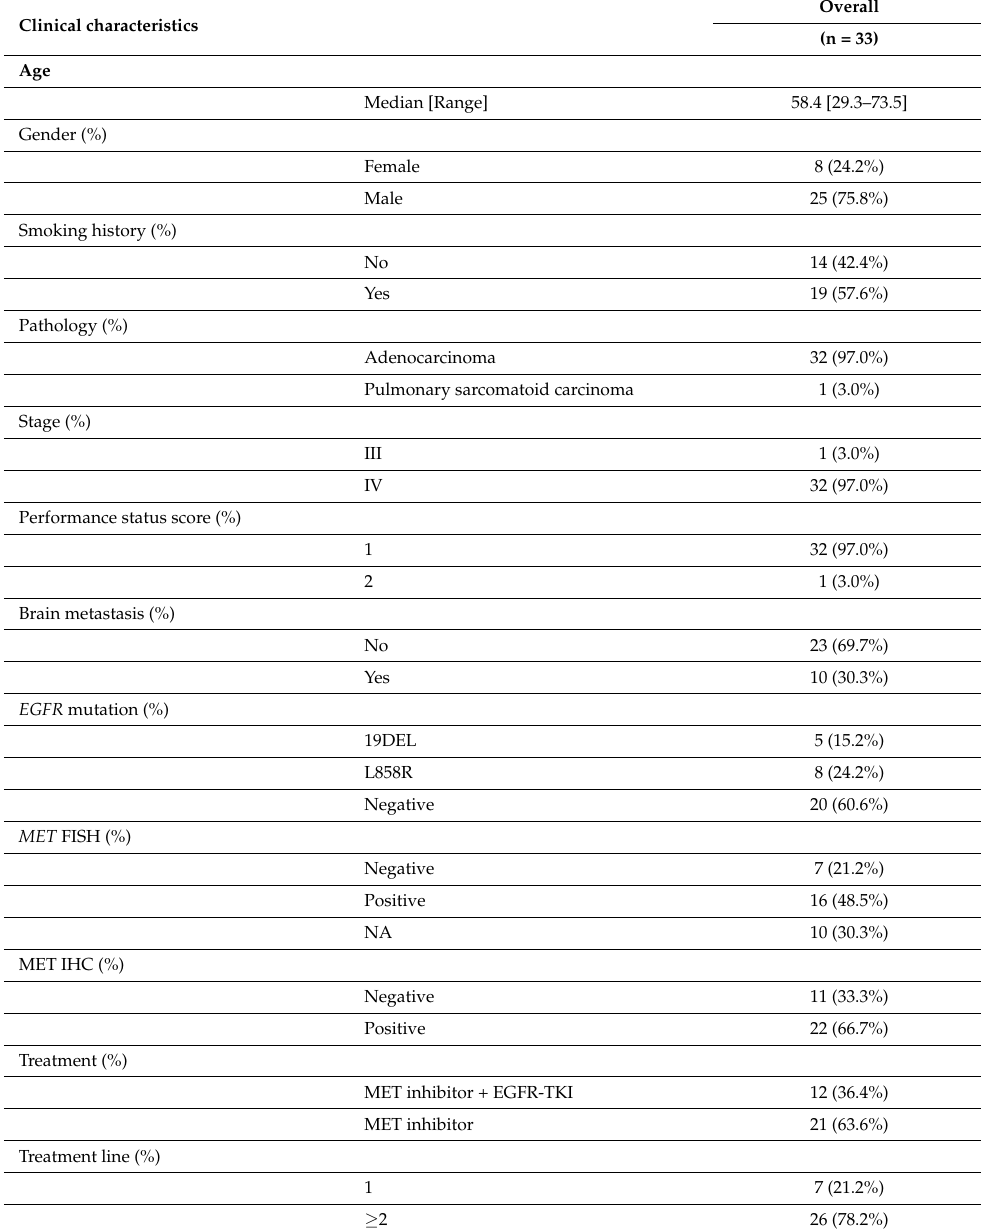
Table 1. The clinicopathological characteristics and treatment strategies of the enrolled patients. Clinical